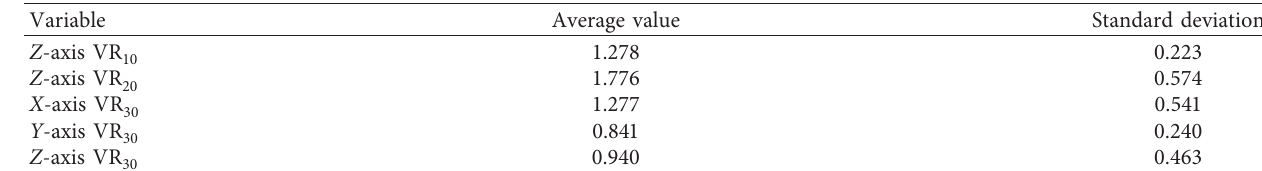
Table 5: Averages and standard deviations of VR